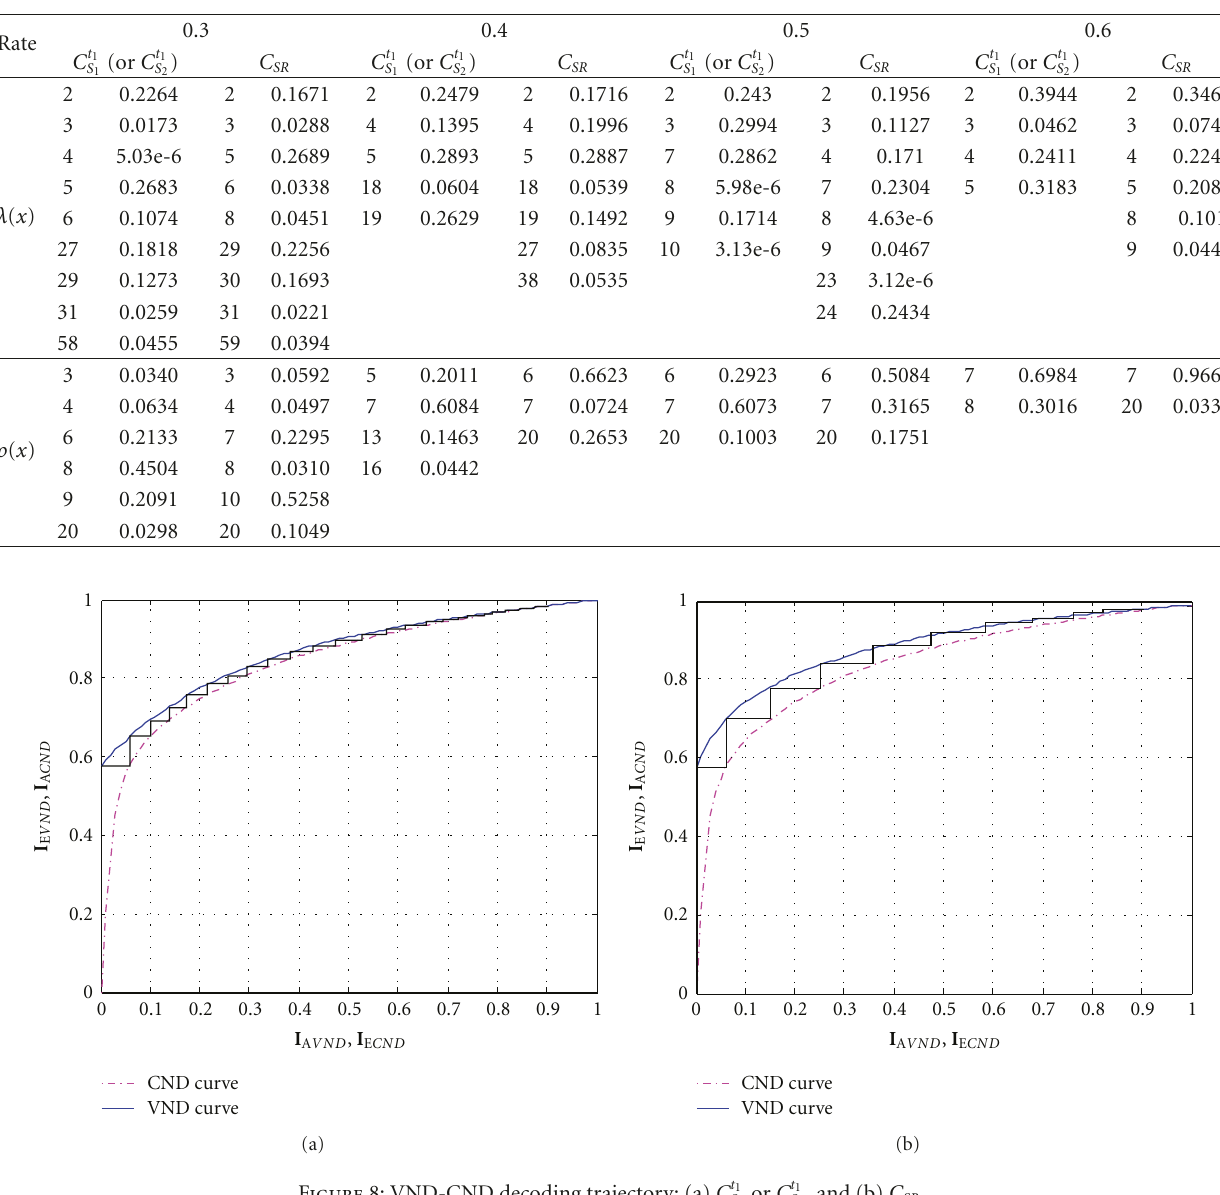
Table 2: Code profile from the optimization algorithm.